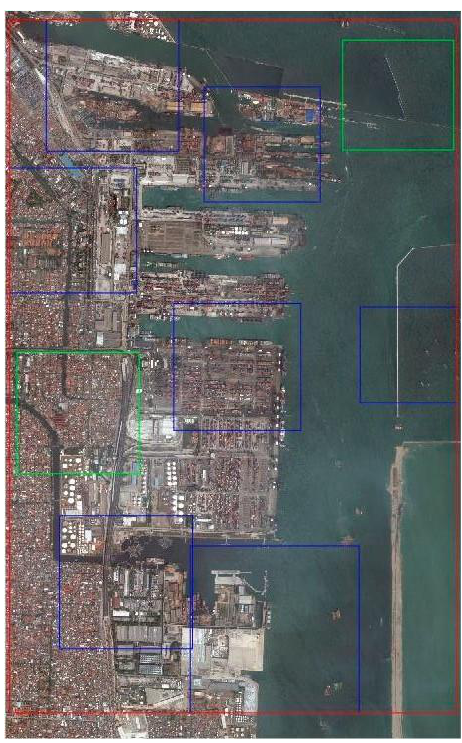
Figure 7. Detection on Jakarta Port in Indonesia